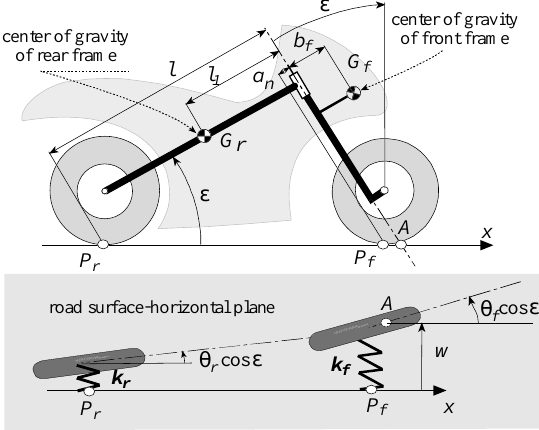
Fig. 2. Model for the evaluation of Tire Dominated Modes.